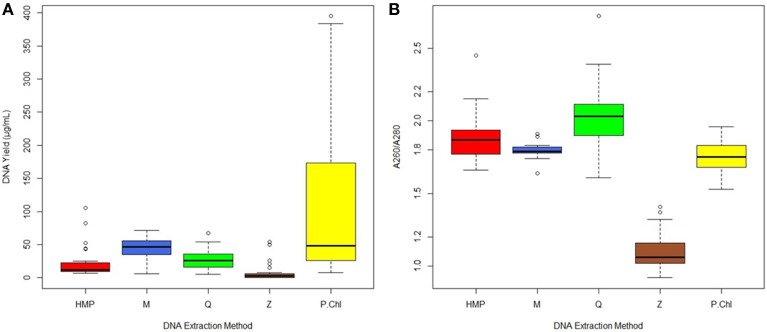
(A) DNA yield (μg/mL) from fecal samples (n = 27 samples per method), (B) DNA quality (A260/A280 nm ratios) from fecal samples (n = 27 samples per method). Median values are indicated by the solid line within each box, and the box extends to upper and lower quartile values. Outlier data points are indicated by open circles.